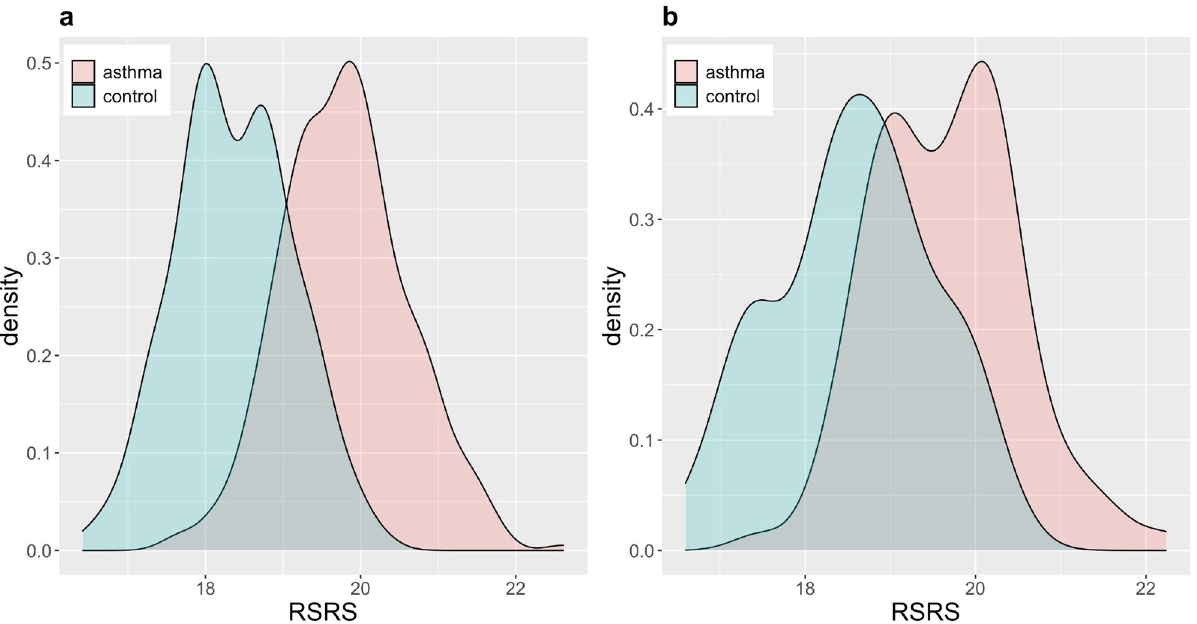
Figure 4. Density plots showing the asthma risk based on RSRS for different groups. ( a ) In training set; ( b ) testing